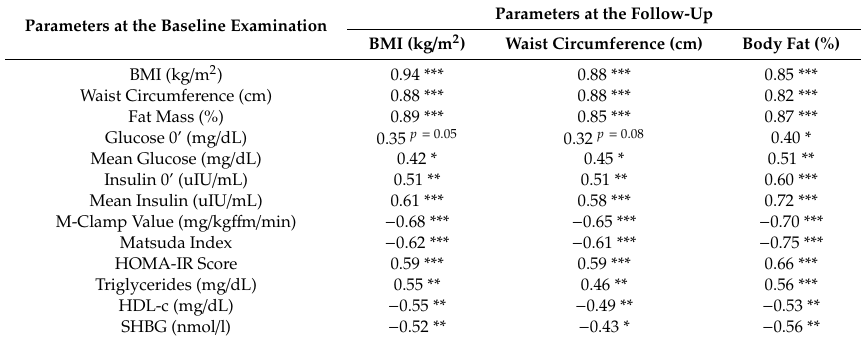
Data are shown as r correlation coe ffi cient. Significance levels are indicated by asterisks (*, p < 0.05; **, p < 0.01; ***, p < 0.001). Correlation coe ffi cients were estimated by Spearman’s correlation for all parameters. BMI, body mass index; HDL-c, high-density lipoprotein cholesterol; HOMA-IR, homeostasis model assessment of insulin resistance; M-clamp value, insulin sensitivity estimated with the euglycaemic hyperinsulinaemic clamp technique; SHBG, sex hormone-binding